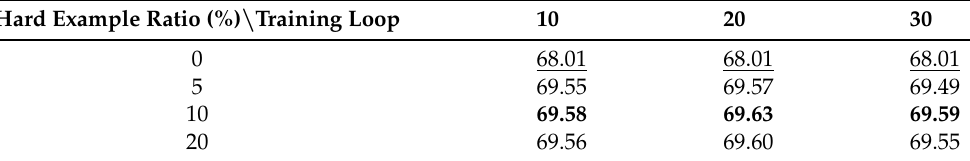
Table 3. The comparative experimental results of HEM with different parameters for single-class detection. Among them, the results with underline are the worst, and the results with bold are the best.